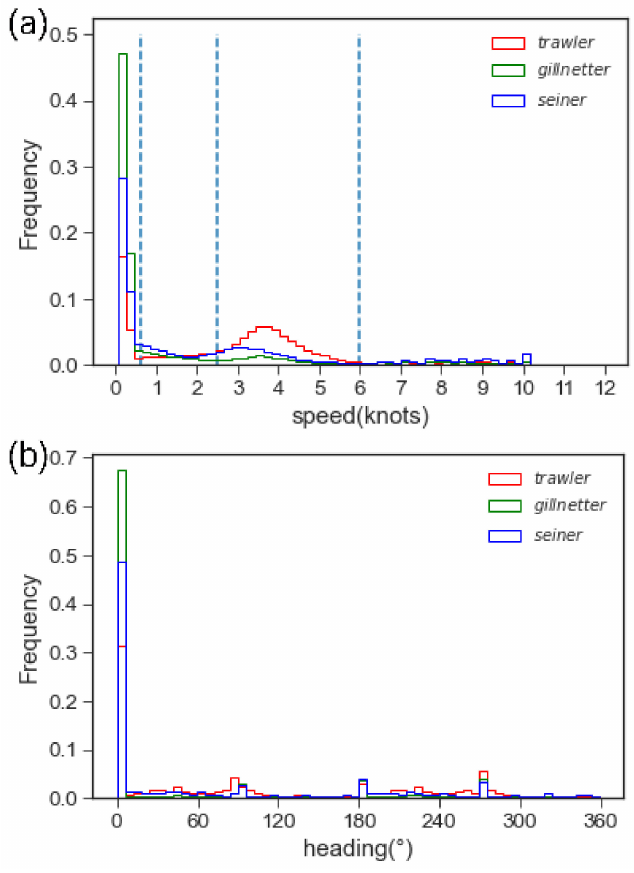
Figure 4. Frequency histograms of speed ( a ) and heading ( b ) for trawlers, gillnetters and